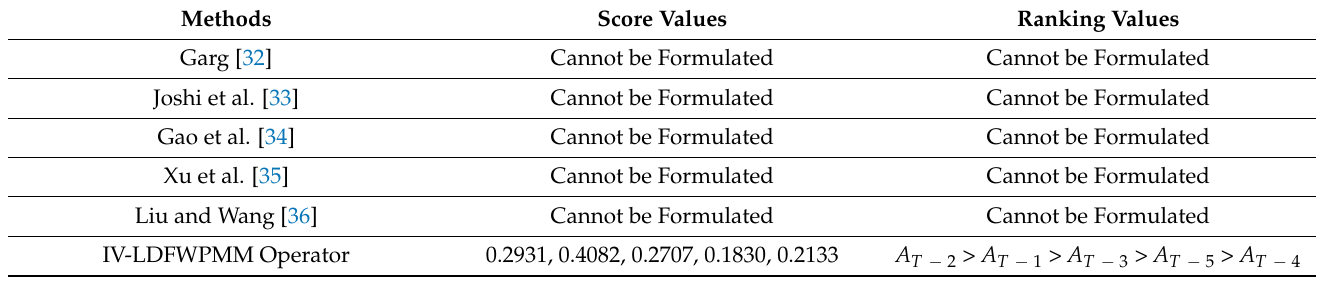
Table 4. Comparative analysis of the presented and some existing operators.